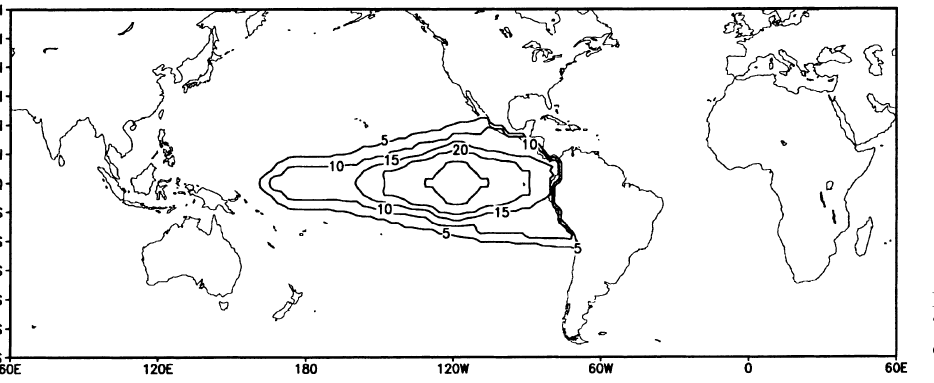
Fig. 3. SST anomalies used in the ‘‘ENSO’’ run. Isolines are in tenths of (cid:176) C every 0.5 (cid:176) C